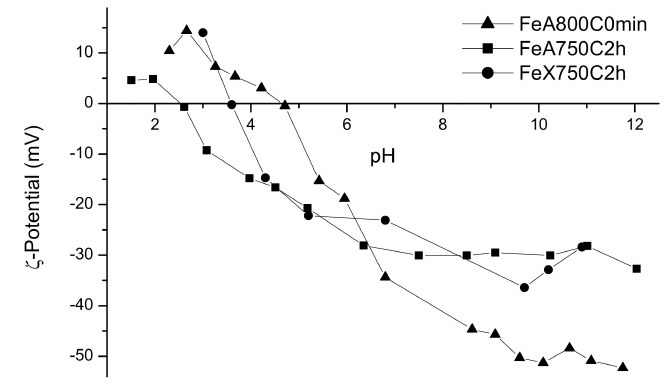
Figure 3. ζ -potential curves of FeA750C2h (squares), FeA800C0min (triangles), and FeX750C2h (circles).